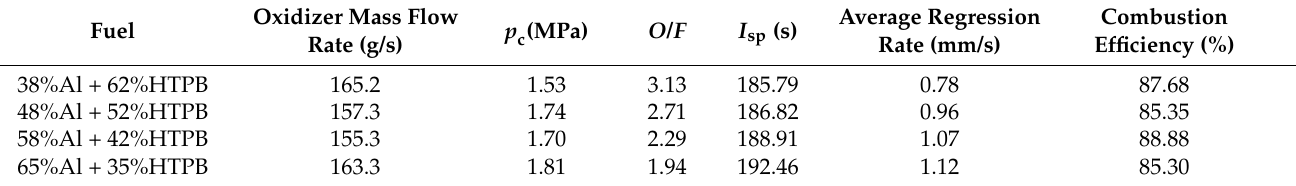
Table 3. Performance